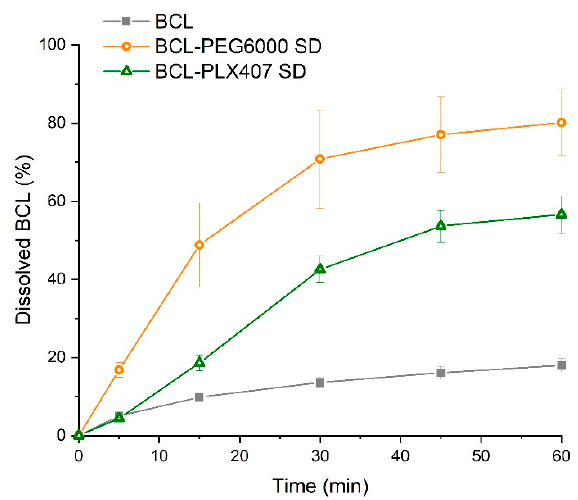
Figure 7. Dissolution profile of tablets containing solid dispersions and raw bicalutamide.